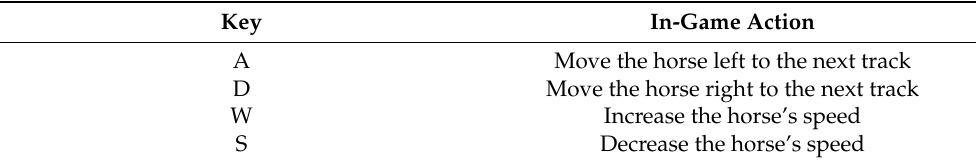
Table 1. Keyboard press and in-game action.